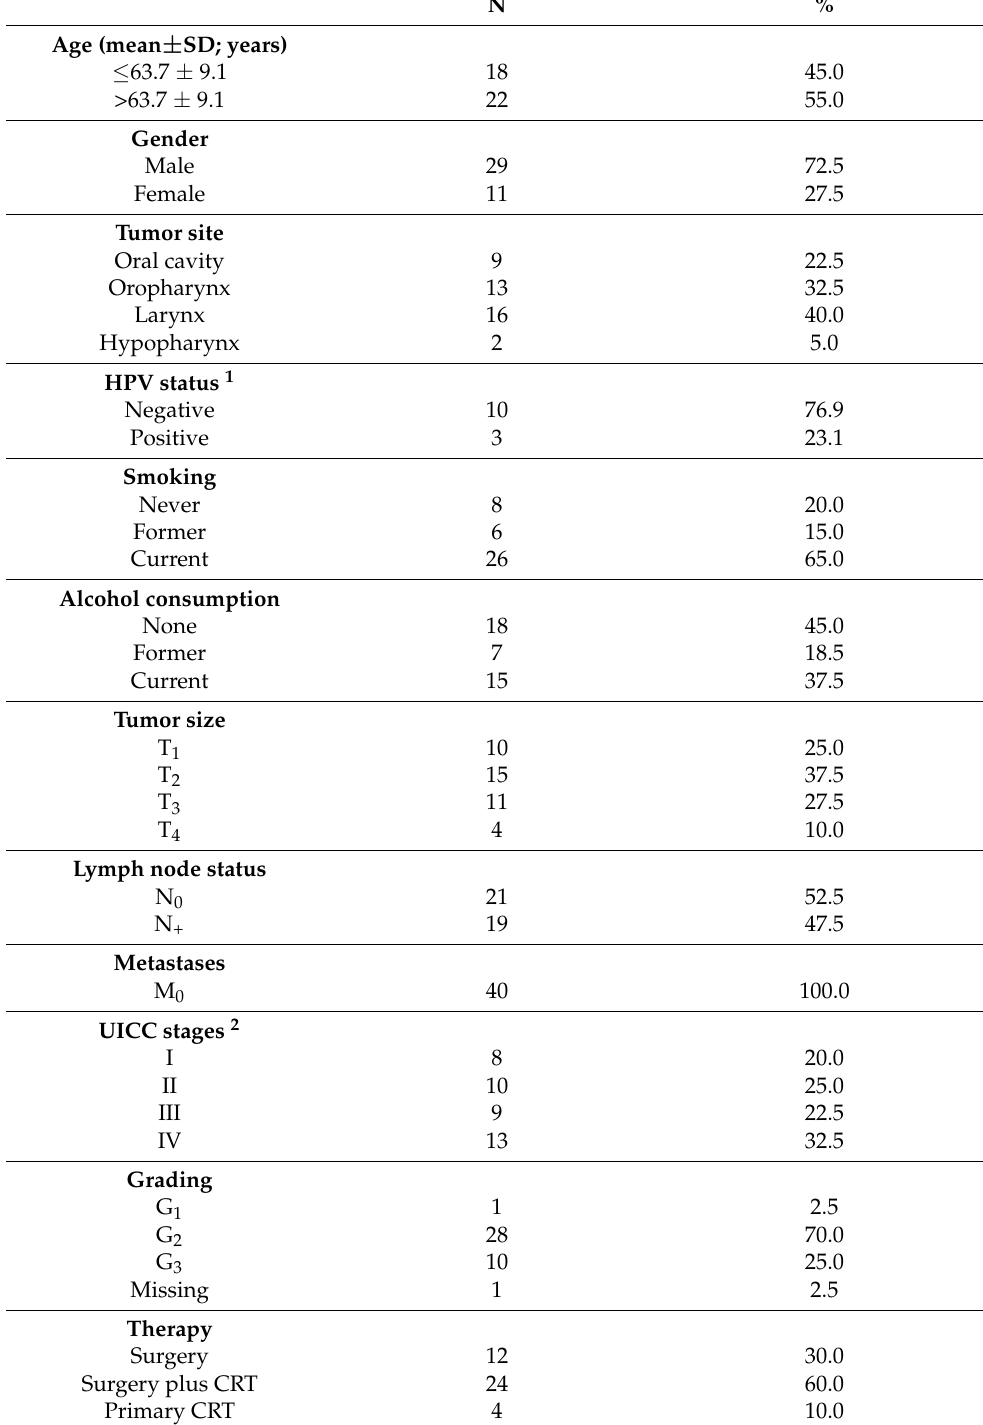
Table 1. Clinicopathological characteristics of the HNC patients (n =